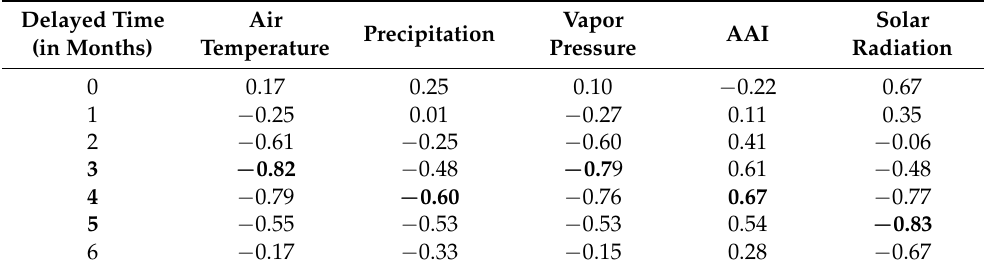
Table 2. The hysteretic response relations between the TCO and different meteorological factors.